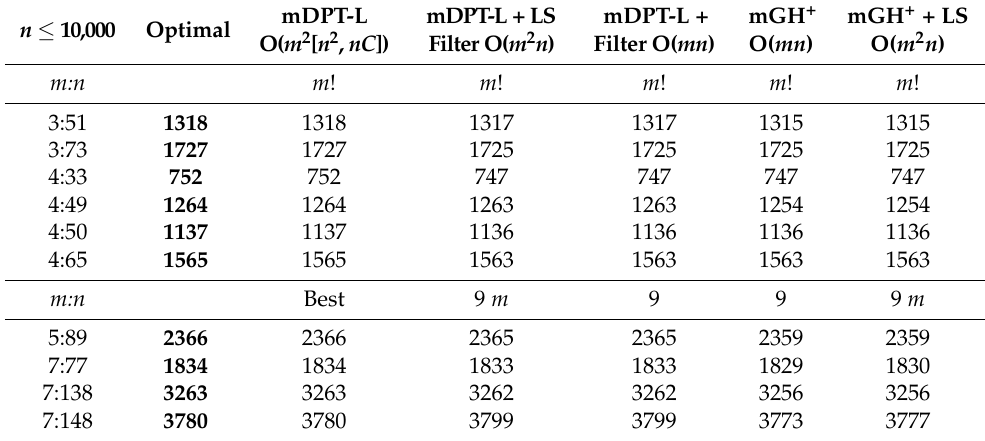
Table 10. Results (total profits) of irregular datasets ( m = 3–7, n ≤ 10,000). n ≤